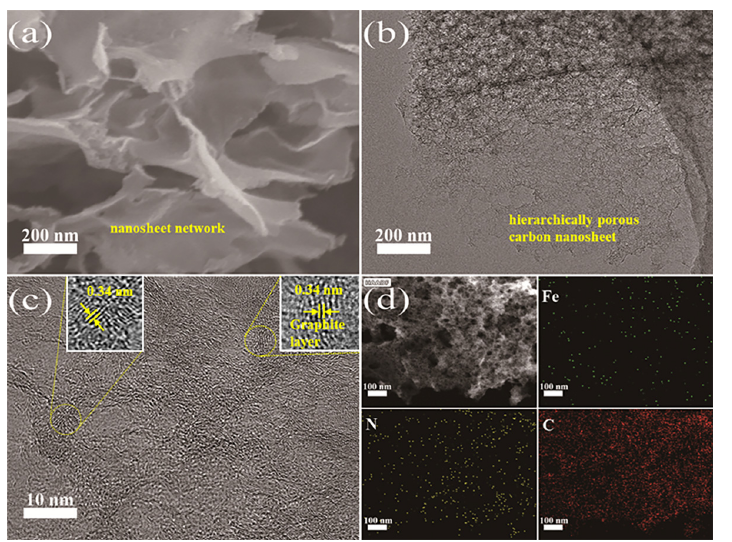
Figure 1. ( a ) SEM, ( b ) TEM and ( c ) HRTEM of Fe-N-CNSs. ( d ) HAADF-STEM and corresponding elemental mapping images of Fe-N-CNSs.